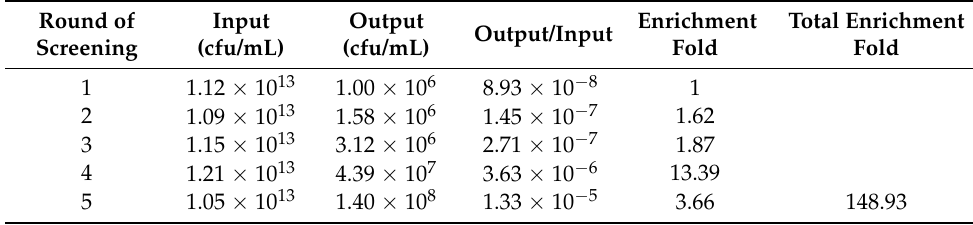
Table 2. Phage library from five rounds of